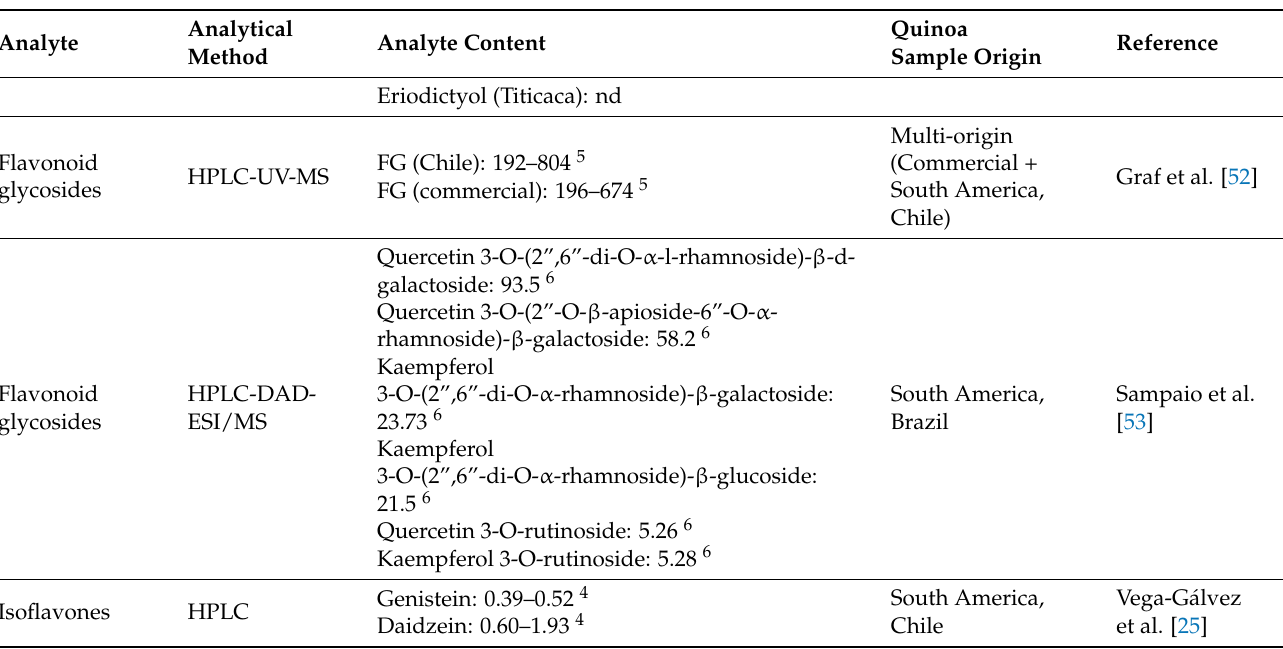
FCM. Folin-Ciocalteu method; FFBB: Fast Blue BB diazonium method; FFC: Free Flavonoid Content; FG: Flavonoid glycosides; TF: Total